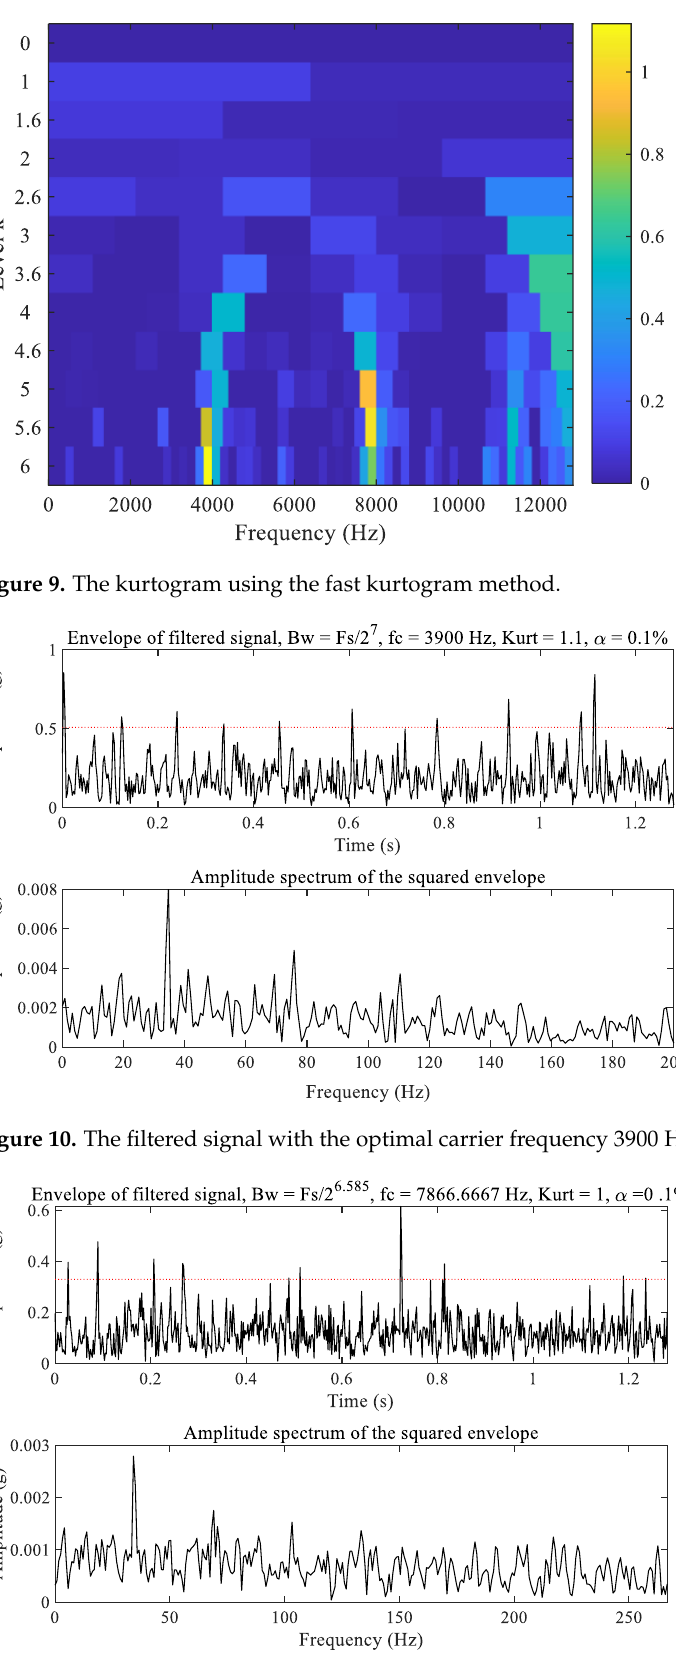
Figure 11. The filtered signal with the optimal carrier frequency 7866 Hz.